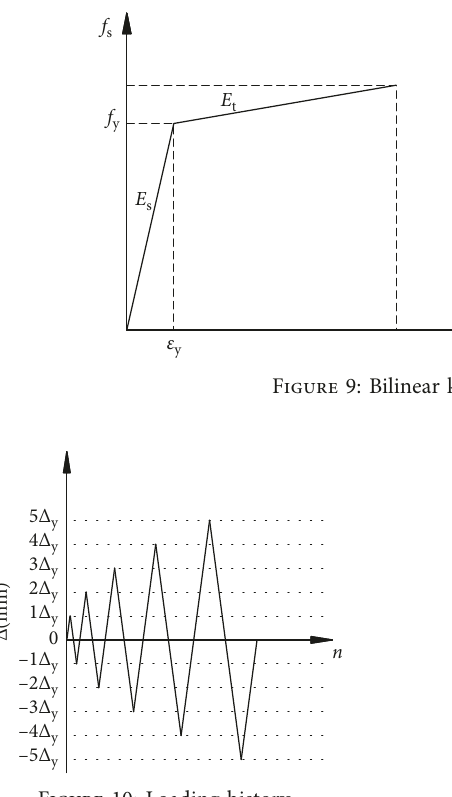
Figure 10: Loading history.